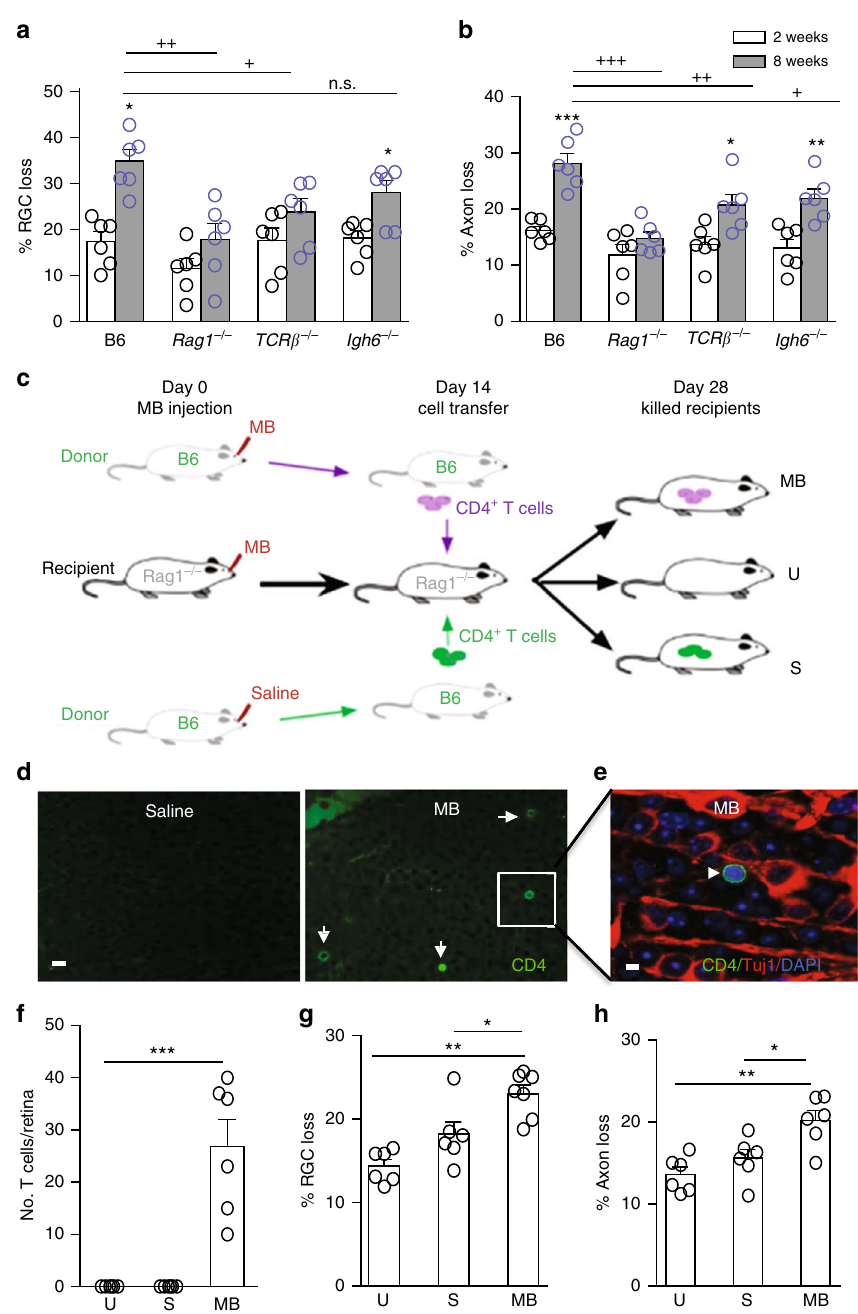
Fig. 2 T cells are required for the prolonged retinal neurodegeneration. a , b Quanti fi cation of RGC ( a ) and axon ( b ) loss in B6, Rag1 − / − , TCR β − / − , and Igh6 − / − mice at 2 (white box) and 8 (gray box) weeks after anterior chamber MB injection. n.s. nonsigni fi cant, + P < 0.05, ++ P < 0.01, +++ P < 0.001 by ANOVA comparing between B6 and indicated mutant mice at 8 weeks post MB injection; * P < 0.05, ** P < 0.01, *** P < 0.001 by ANOVA comparing between 2 and 8 weeks post MB injection of mice with the same genotype ( n = 8/group). c Scheme of adoptive CD4 + T-cell transfer. Both donor B6 and recipient Rag1 − / − (Rag1 − / − ) mice were injected with MB or saline into the anterior chamber. Fourteen days later, CD4 + T cells were isolated from the spleens of donor mice and injected via tail vein into Rag1 − / − mice that had received MB injection 14 days earlier. d – h Fourteen days post cell transfer, T-cell in fi ltration and RGC and axon loss in Rag1 − / − mice were analyzed. Retinal fl at-mounts were stained with an anti-CD4 antibody (green), Tuj1 (red), and DAPI (blue). Shown are anti-CD4-stained ( d ) and overlay ( e , from inset of d ) images of retinal fl at-mounts taken from Rag1 − / − recipient mice receiving CD4 + T cells from saline- or MB-injected B6 mice. Arrows point to CD4 + cells. Scale bar: 25 µ m ( d ) and 10 µ m ( e ). Quanti fi cation of in fi ltrated T cells ( f ), and RGC ( g ) and axon ( h ) loss in glaucomatous Rag1 − / − recipient mice that received no CD4 + T cells (U uninjected) or donor CD4 + T cells from saline- injected (S or normal IOP donor) and MB-injected (MB or glaucomatous donor) B6 mice 2 weeks post cell transfer. * P < 0.05; ** P < 0.01 by ANOVA ( n =